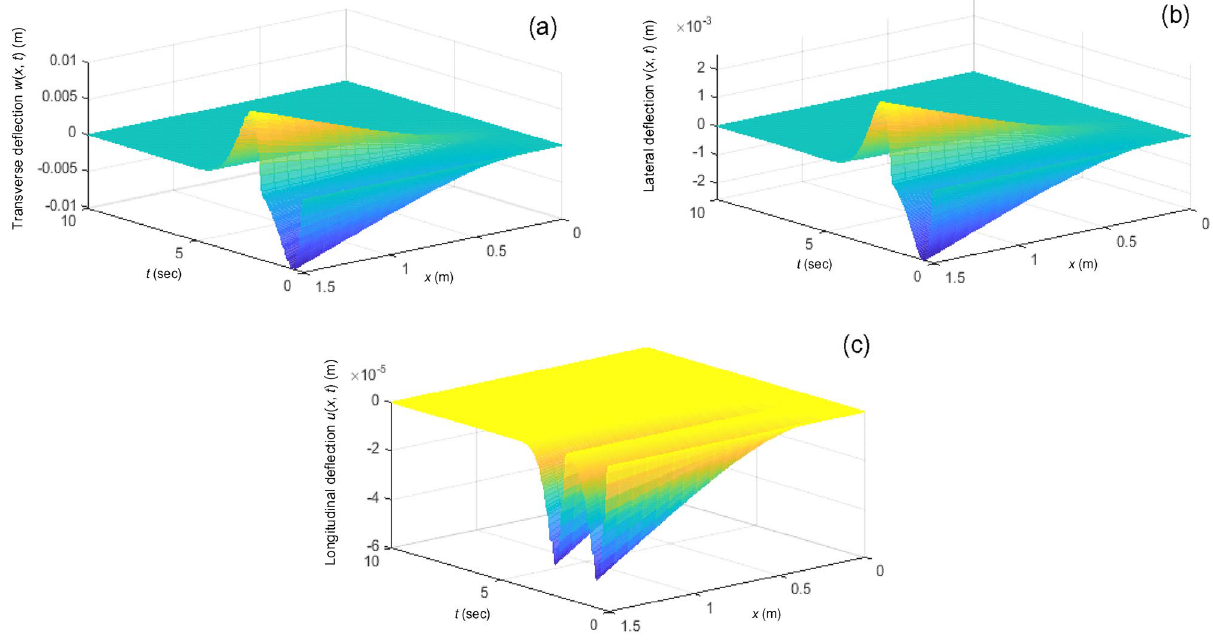
Figure 5. Vibrations of the three-dimensional flexible beam under the proposed control law: ( a ) Transverse vibration w ( x , t ), ( b ) lateral vibration v ( x , t ), and ( c ) longitudinal vibration u ( x , t ).